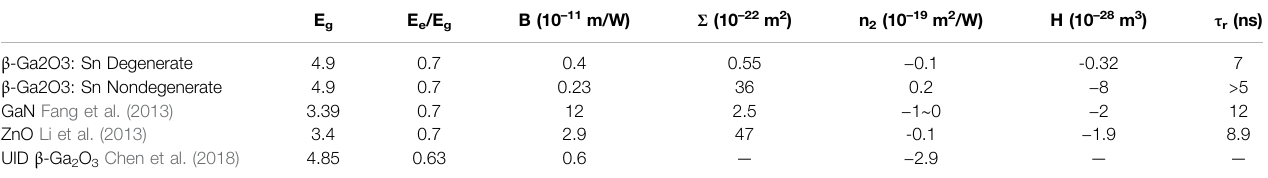
TABLE3| Photo-physicalparametersof β -Ga 2 O 3 :Sn,GaN,ZnOandUID β -Ga 2 O 3 . E g ,bandgap; E e /E g ,relativephotonenergy; β ,TPAcoef fi cient; σ ,FCAcross-section; n 2 , kerr refractive index; η , FCR volume; τ r , carrier